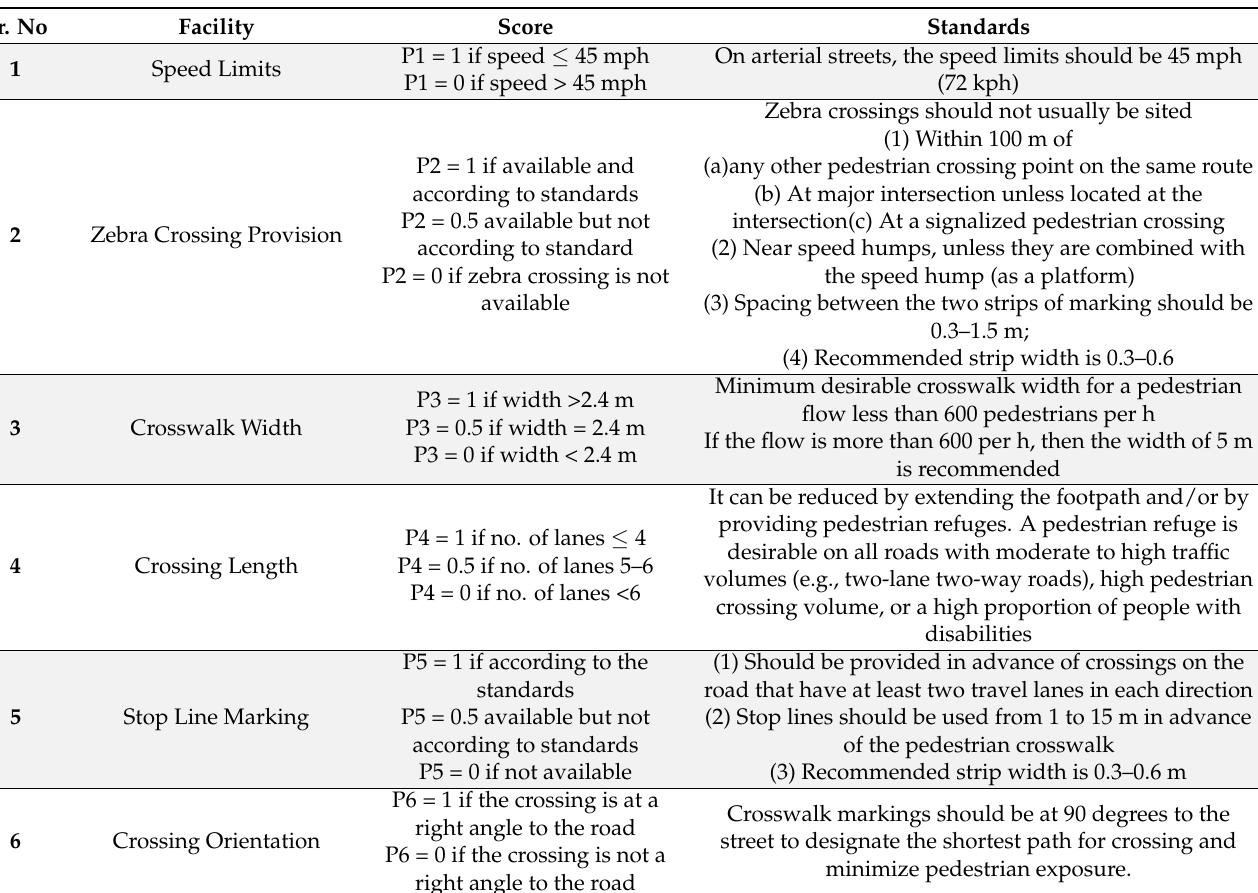
Table 3. Pedestrian crossing indicators and their scores based on standard